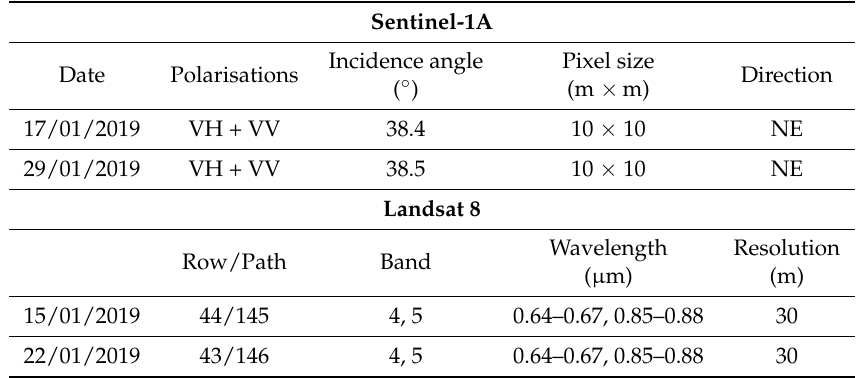
Table 1. Details of the Sentinel-1 and Landsat 8 images used in this